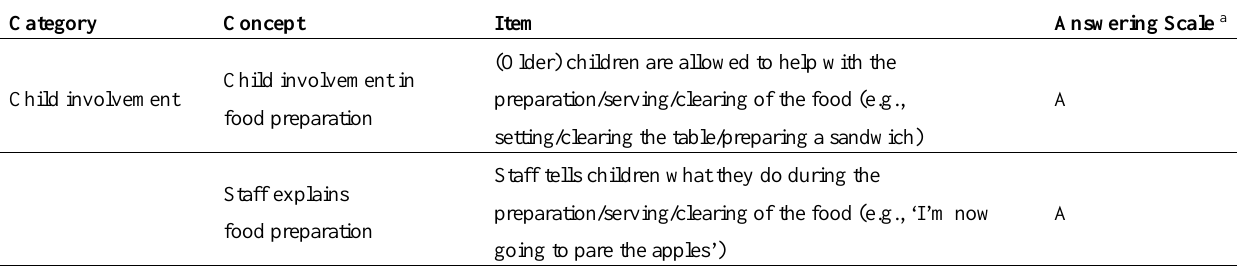
Table 1. Childcare staff food practices assessed in the questionnaire for childcare